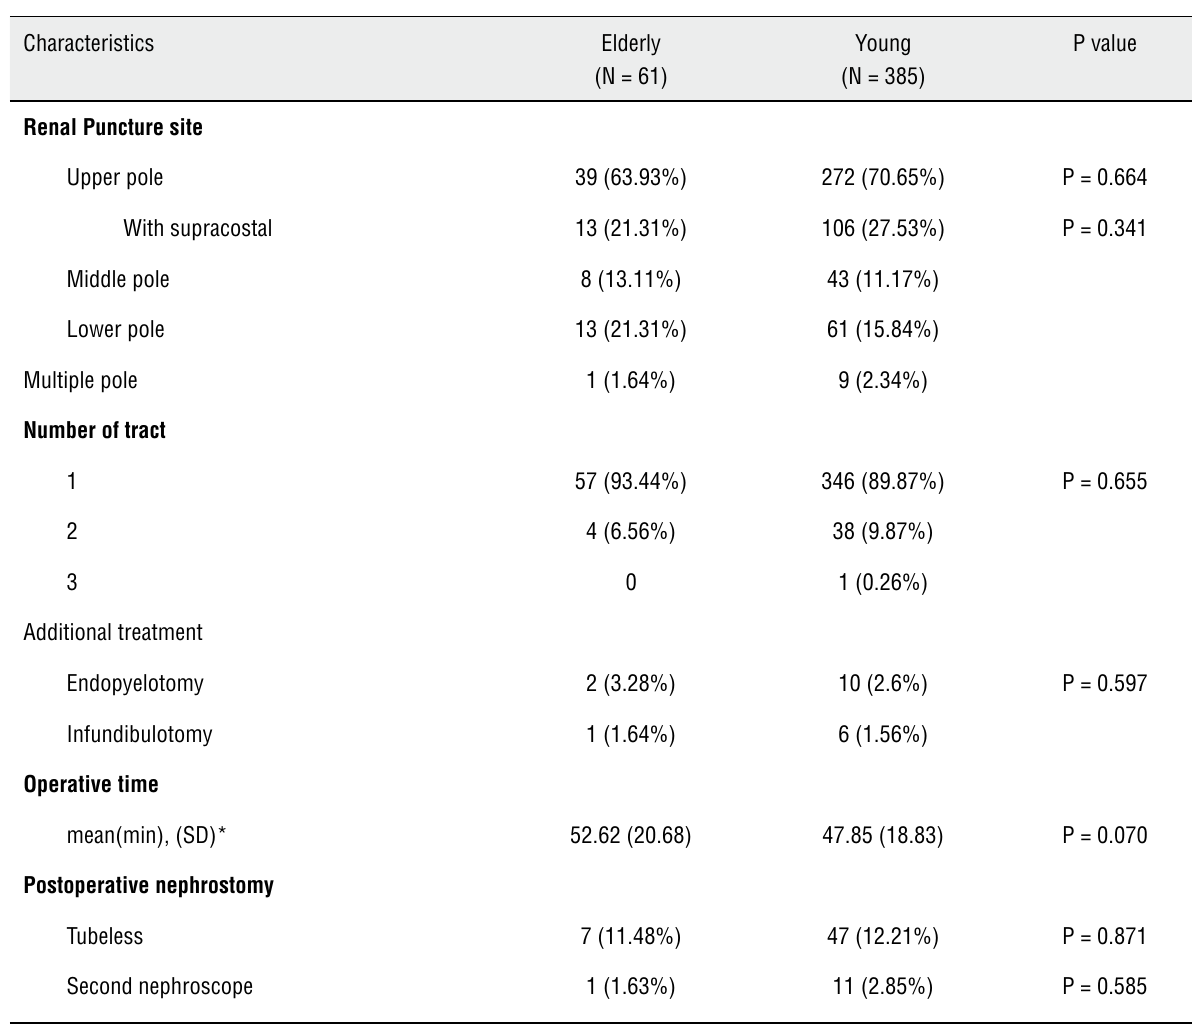
Table 2 - Operative Characteristics.